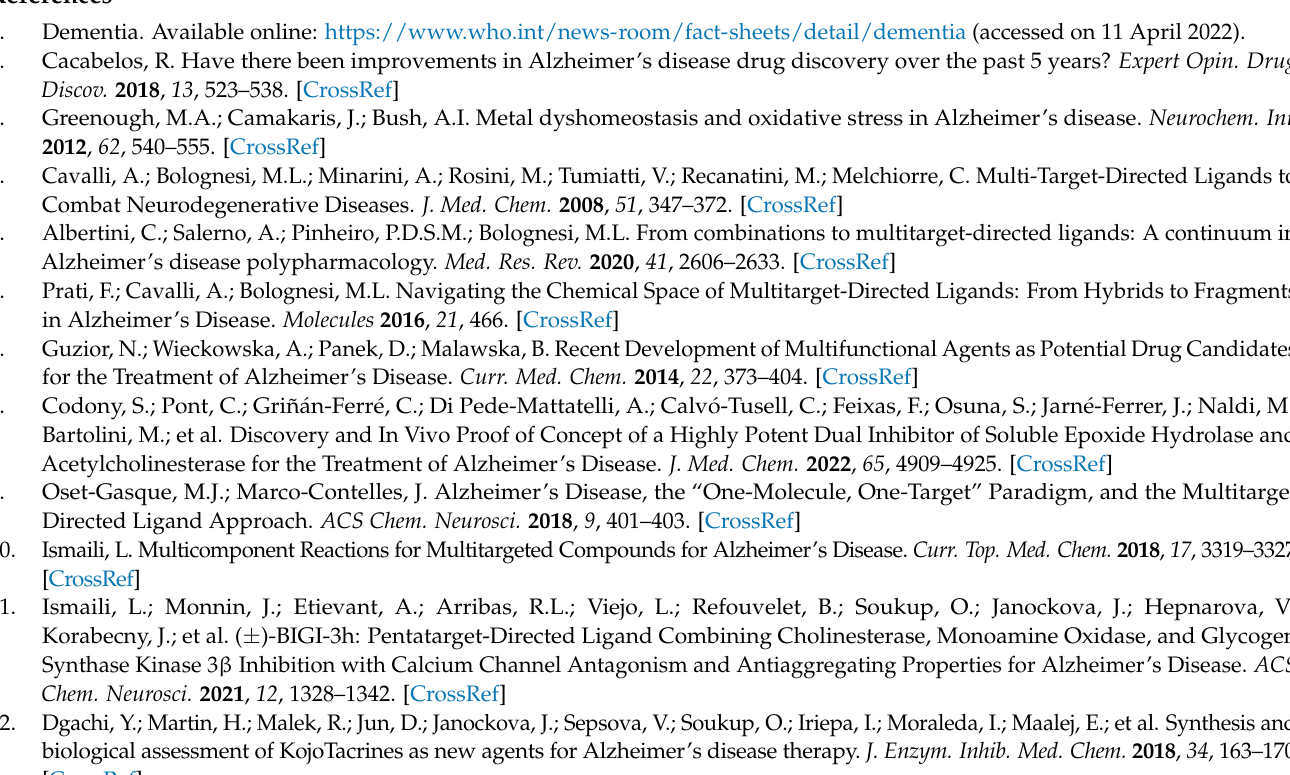
Supplementary Materials: The NMR spectras are available in the following supporting information which can be downloaded at: https://www.mdpi.com/article/10.3390/molecules28010071/s1. Fig- ure S1: 1 H NMR spectrum of compound 4a; Figure S2: 13 C NMR spectrum of compound 4a; Figure S3: 1 H NMR spectrum of compound 5a; Figure S4: 13 C NMR spectrum of compound 5a; Figure S5: 1 H NMR spectrum of compound 4b; Figure S6: 13 C NMR spectrum of compound 4b; Figure S7: 1 H NMR spectrum of compound 5b; Figure S8: 13 C NMR spectrum of compound 5b; Figure S9: 1 H NMR spectrum of compound 4c; Figure S10: 13 C NMR spectrum of compound 4c; Figure S11: 1 H NMR spectrum of compound 5c; Figure S12: 13 C NMR spectrum of compound 5c; Figure S13: 1 H NMR spectrum of compound 4d; Figure S14: 13 C NMR spectrum of compound 4d; Figure S15: 1 H NMR spectrum of compound 5d; Figure S16: 13 C NMR spectrum of compound